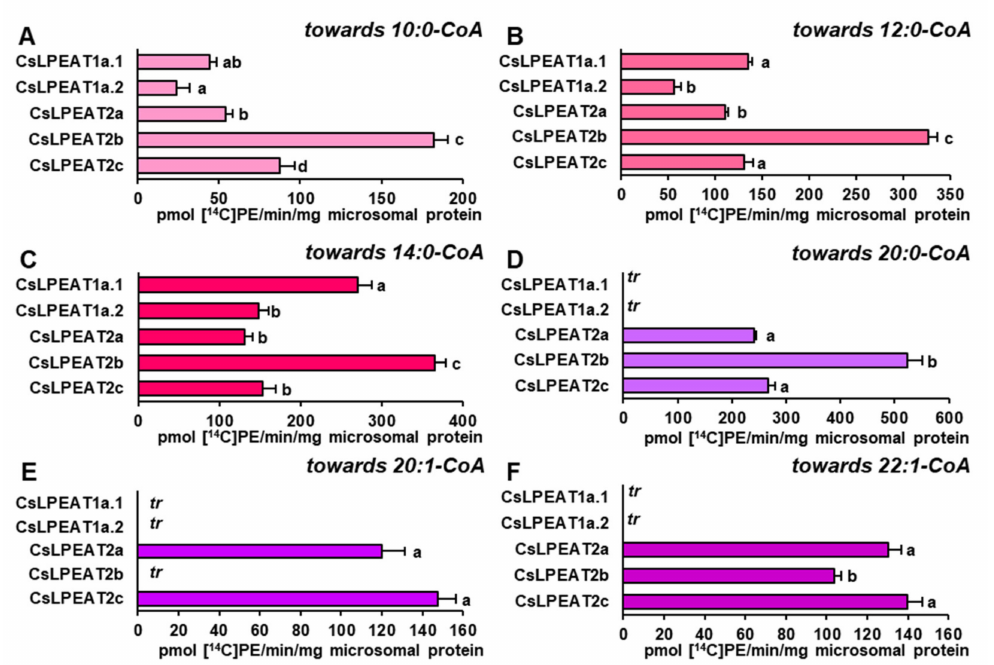
Figure 8. Acyl-CoA specificity of Cs LPEAT isoforms towards short and very long chain acyl-CoA donors and 18:1-LPE as an acyl acceptor, in yeast system. Panel ( A – C ) correspond to medium-chain fatty acids (10:0-CoA, 12:0-CoA and 14:0-CoA, respectively), and panel ( D – F ) toward VLCFA (20:0-CoA, 20:1-CoA and 22:1-CoA, respectively). Error bars indicate the SD between at least three repeats ( n ≥ 3). Statistical analysis of the difference in activity of each isoform at various tested temperatures were done by one-way ANOVA followed by Tukey’s test. Different letters indicate significant difference ( p ≤